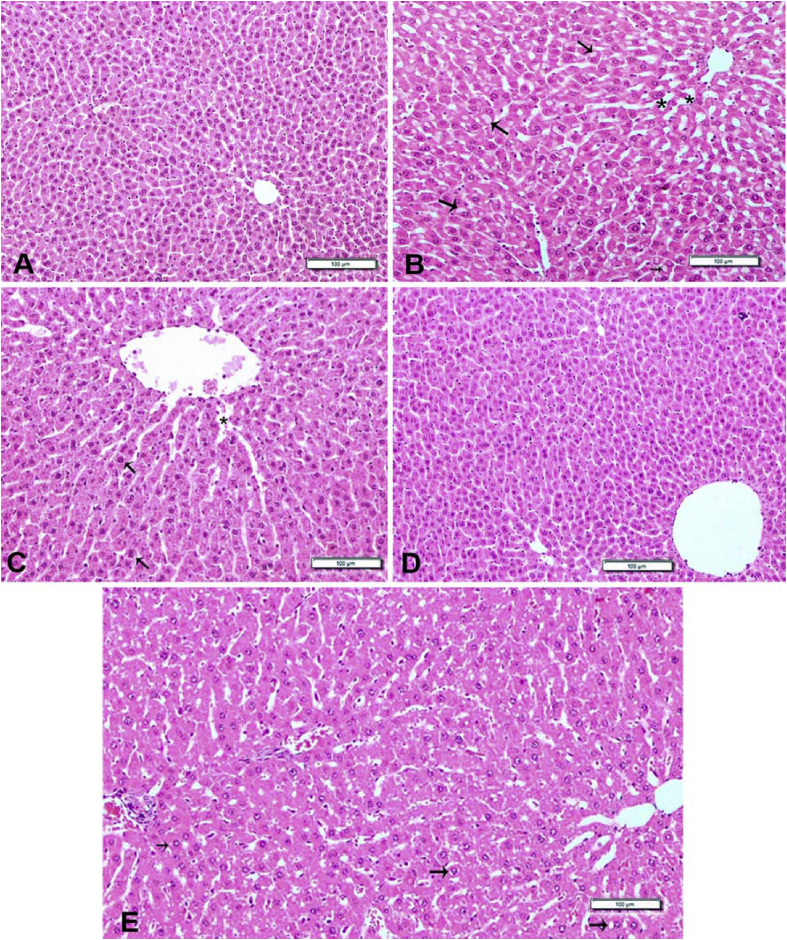
Hematoxylin and eosin-stained sections of liver. A) Control group: Normal histological appearance. B) Diabetic group: Disseminated vacuolization (arrows) in the hepatocytes and dilation of sinusoids (stars). C) Diabetic + L. nobilis treated group: Slight hydropic degeneration in the some hepatocytes (arrows) and dilation of sinusoids (star). D)L. nobilis-fed group: Almost normal histological appearance of the liver. E) Diabetic + drug- treated group: rat administered with acarbose showing slight hydropic degeneration (arrows) and dilation of sinusoids. Bar = 100 μm.